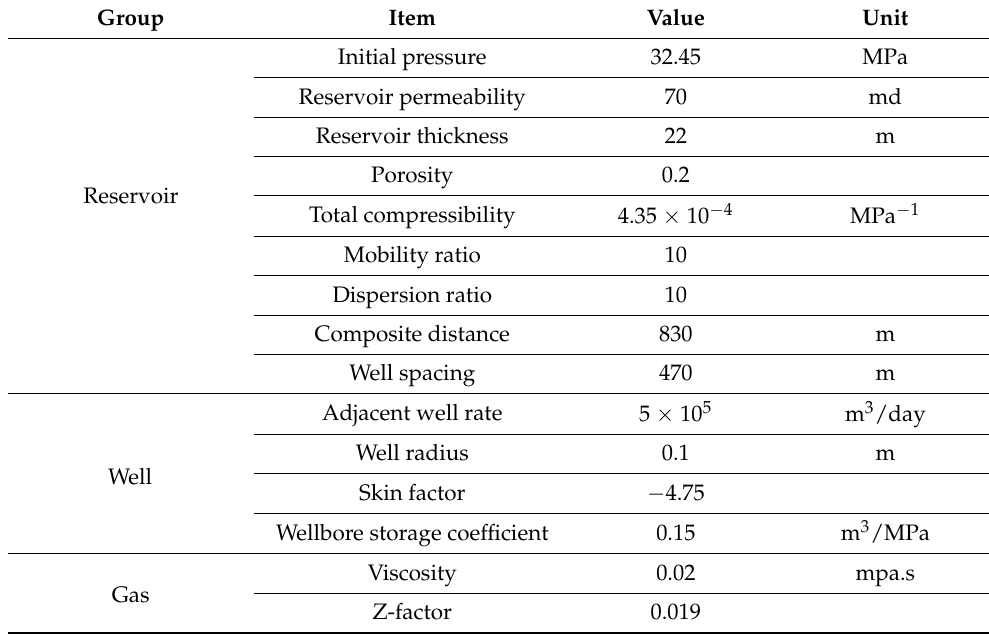
Table 6. The reservoir, well, and gas properties in pressure transient analysis of case 2. Group Item